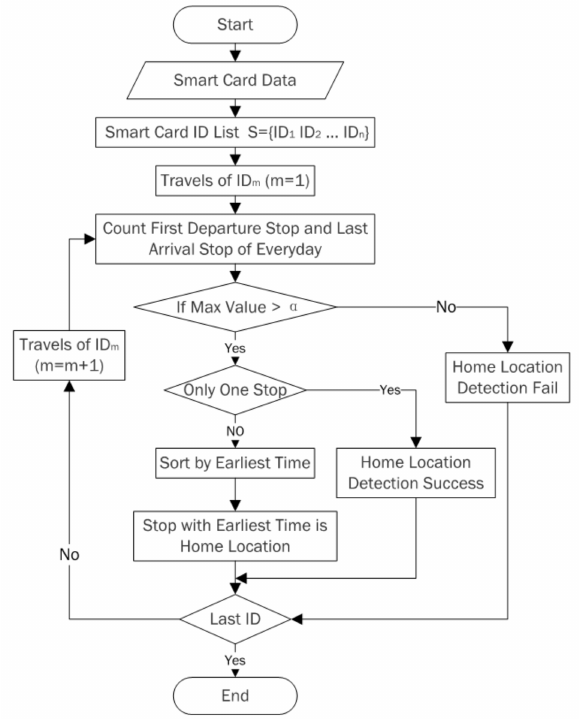
Figure 2. The flowchart of the home location detection